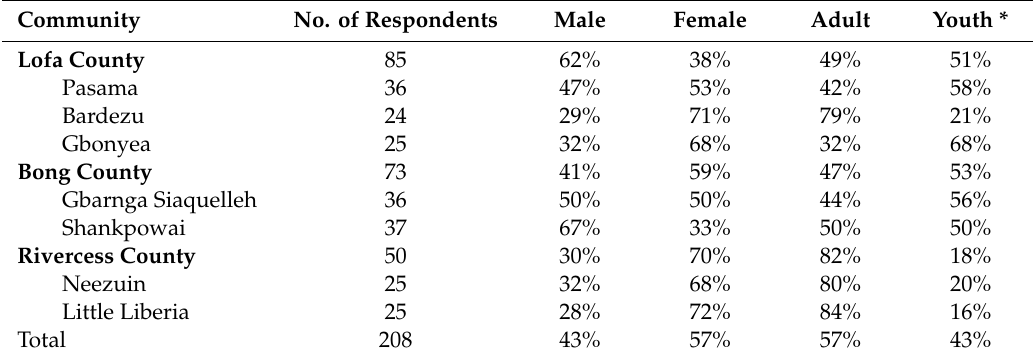
Table 1. Age and Gender of Baseline Respondents, Percentage in Program Communities.